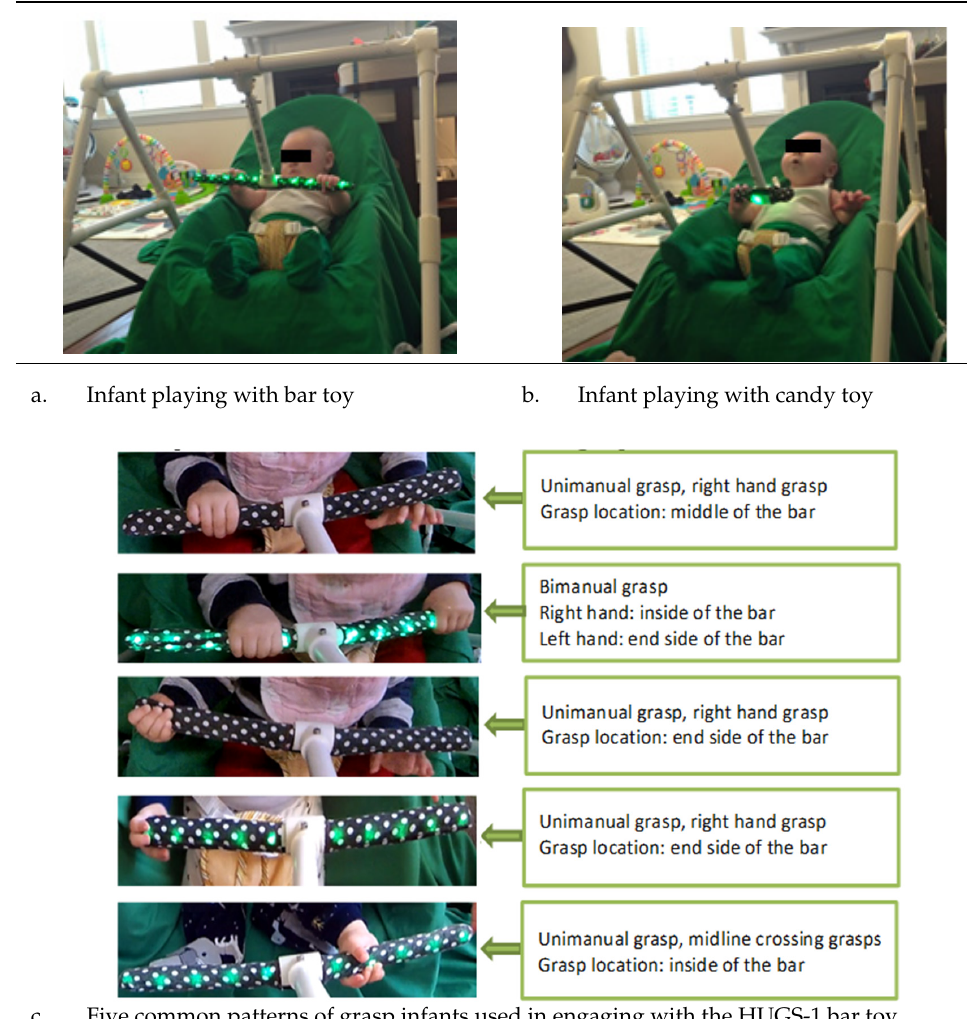
Table 1. Infant interaction with HUGS-1.